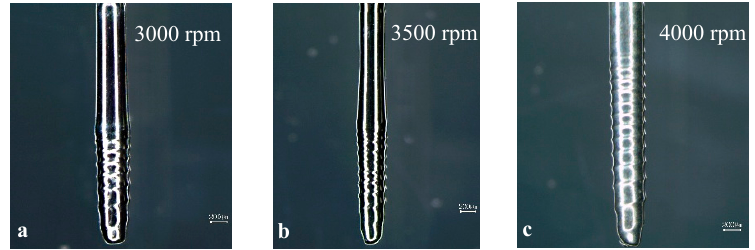
Figure 5. The spiral electrodes fabricated by different rotation speeds.